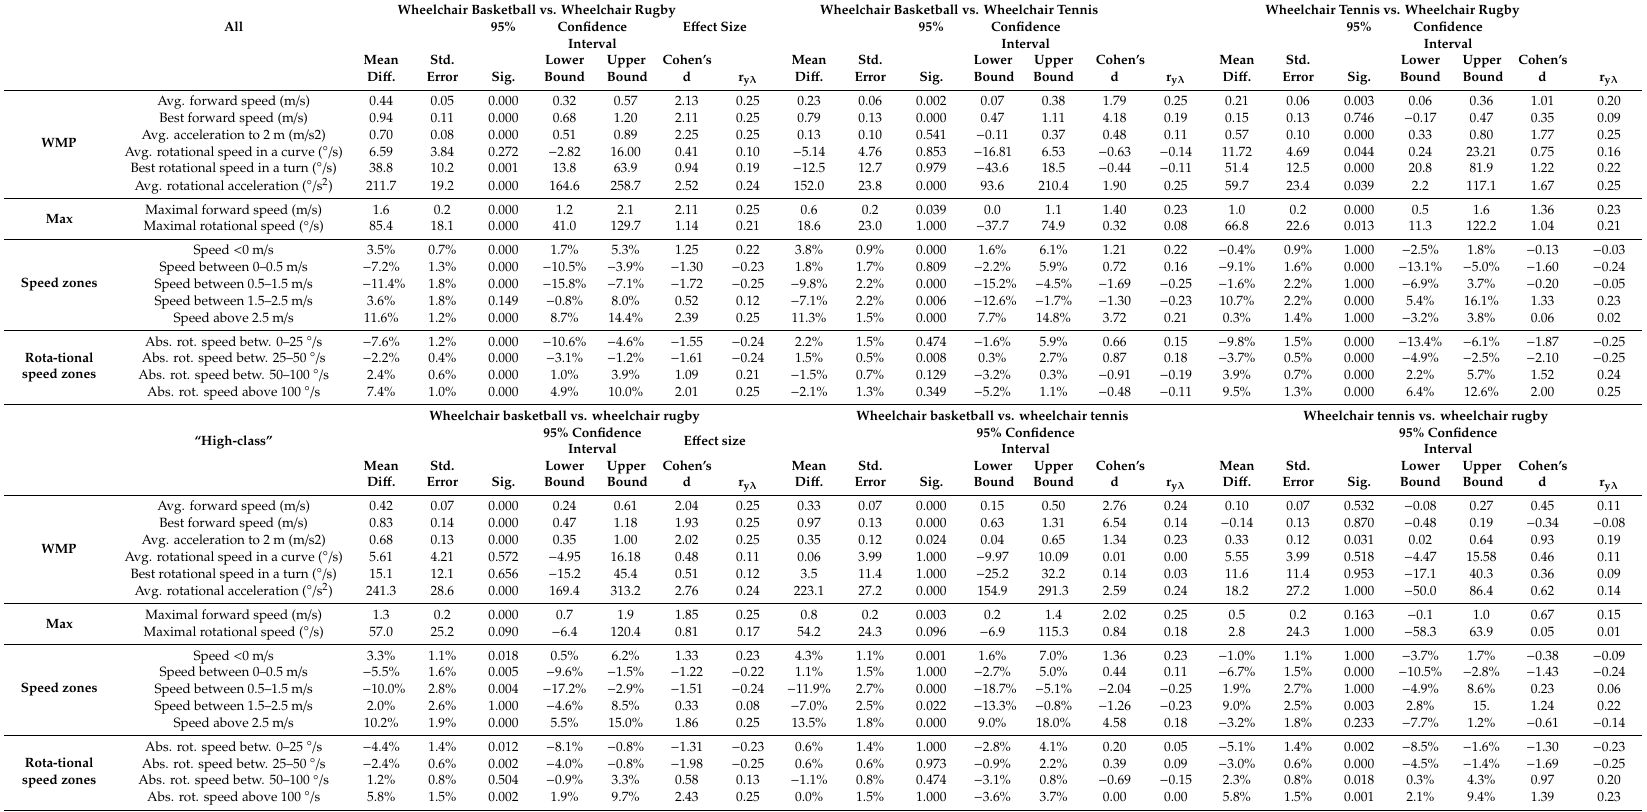
Table A1. All performance di ff erences between groups, expressed in mean di ff erence; standard deviation; significance level of the one-way ANOVA with Bonferroni post hoc; upper and lower boundaries of the 95% confidence interval; the e ff ect size Cohen’s d and the e ff ect size correlation r y λ . With Cohen’s d = Mean 1 r Y λ = d √ [28]. The upper table shows the overall outcomes, and the bottom table only the “high-class” athletes (WB, 3 + ; WR, 2.5 + ; WT, all). d 2 + 4 WheelchairBasketballvs. WheelchairRugby WheelchairBasketballvs. WheelchairTennis WheelchairTennisvs. WheelchairRugby